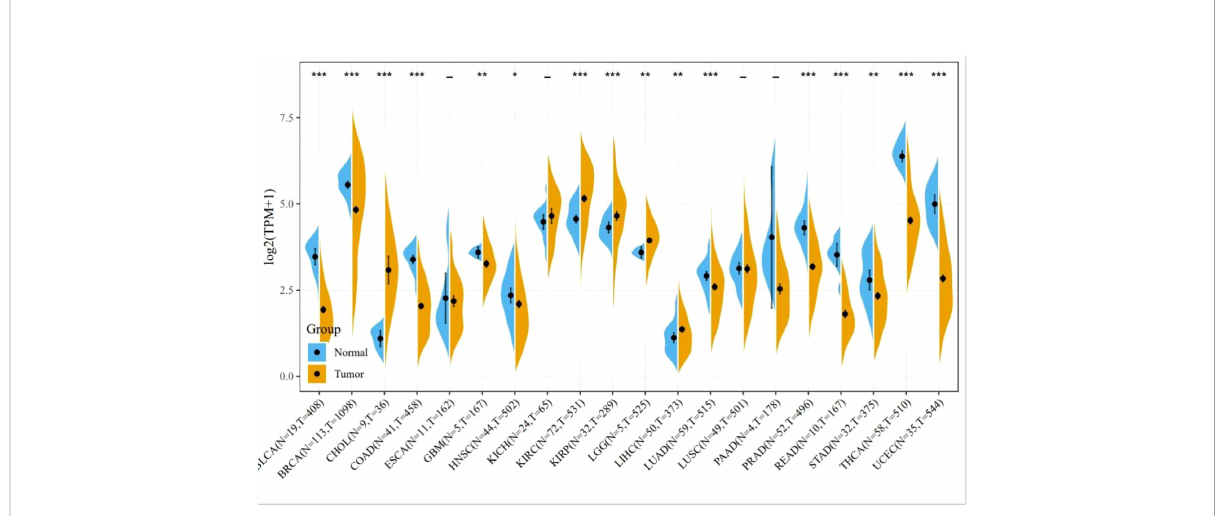
FIGURE 2 Expression of BCL-2 in various tumors. Comparisons of BCL-2 expression levels between tumor tissues from TCGA database and normal tissues from the GTEx database (*P < 0.05, **P < 0.01, ***P <